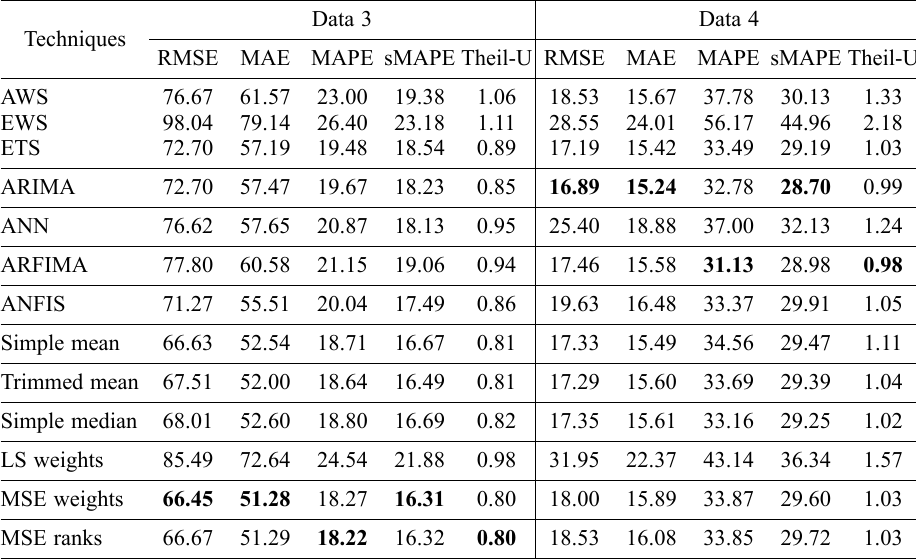
Table 5. Forecasting results of the single models and combining methods for Data 3 and 4 Data 3 Data 4 Techniques